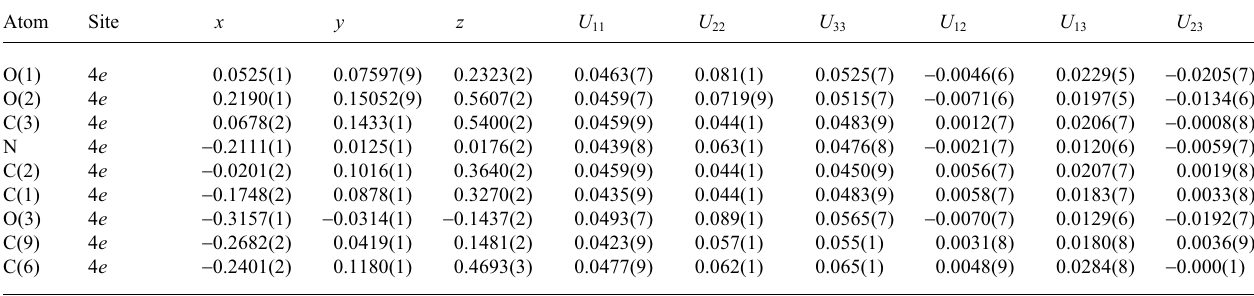
Table 3. Atomic coordinates and displacement parameters (in Å 2 ) .